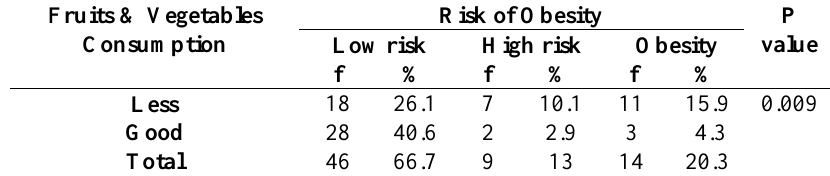
Tabel 4. Coreelation Fruits and Vegetables Consumption with Risk of Obesity using Chi Square